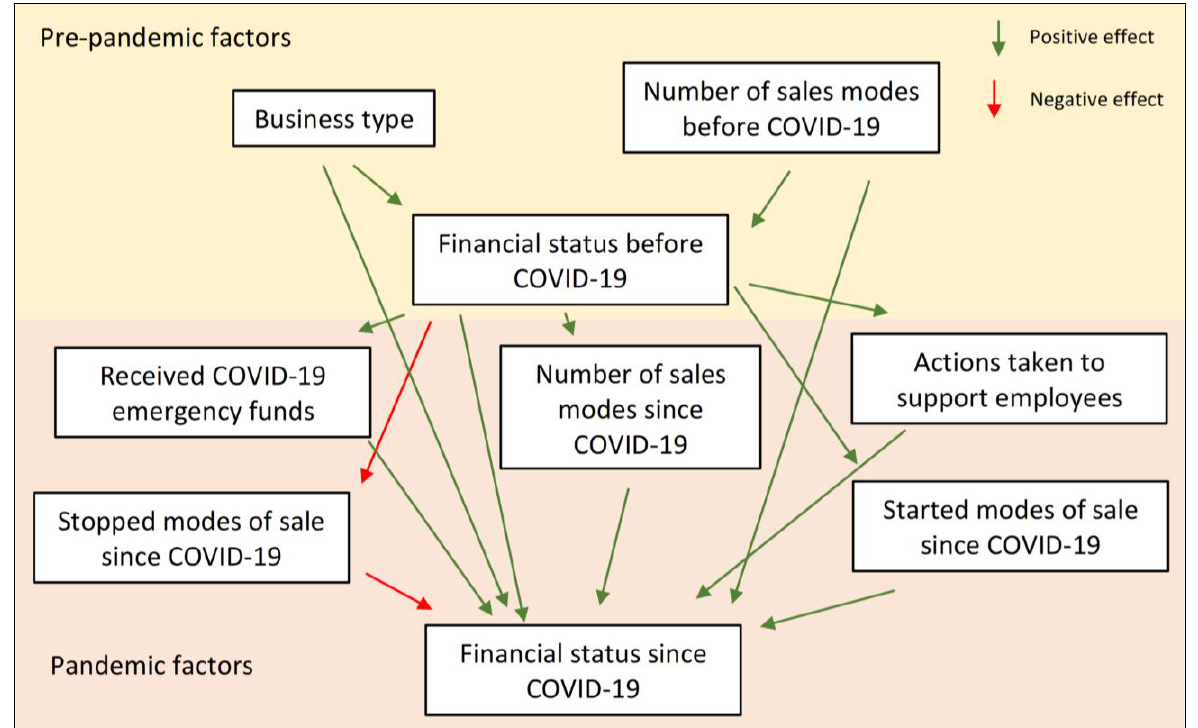
Figure 1. Conceptual